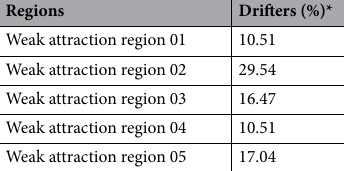
Table 1. Percentage of satellite-tracked drifters with 15 m drogues (SVP) distributed by NOAA’S GDP, with trajectories interpolated in 6 h intervals, that crossed the 2000-m isobath along a region of weak attraction, as indicated in Fig. 3b. The same drifter can be counted more than once if it crossed more than one region of weak attraction. *The percentage is related to the total of 352